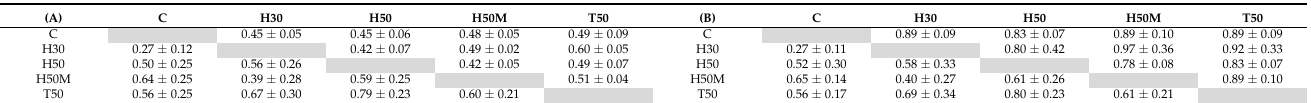
Table 7. β Diversity indices (Sørensen-Dice) observed for the entire (A) and restricted communities (B). Qualitative results are depicted in the upper quadrant and quantitative in the lower